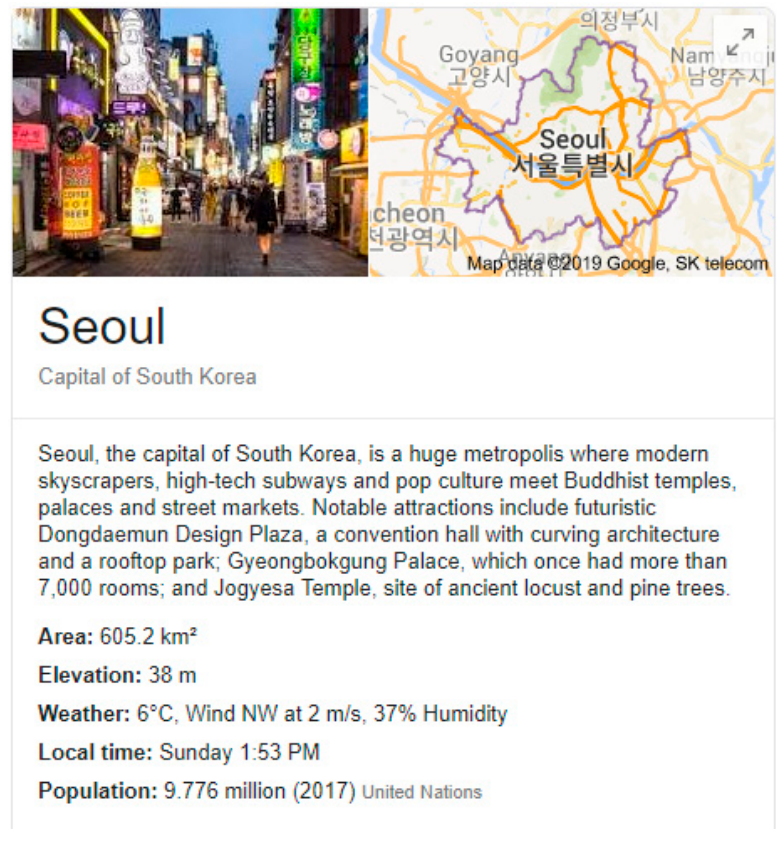
Figure 1. Search result by Google’s Knowledge Graph.